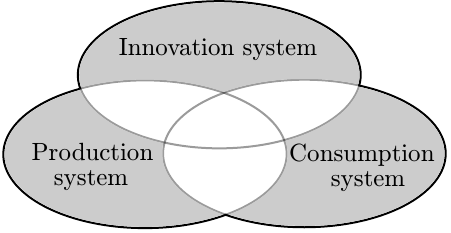
Figure 6: The innovation system as a key to strategic development of logistics (Ericsson 2000).